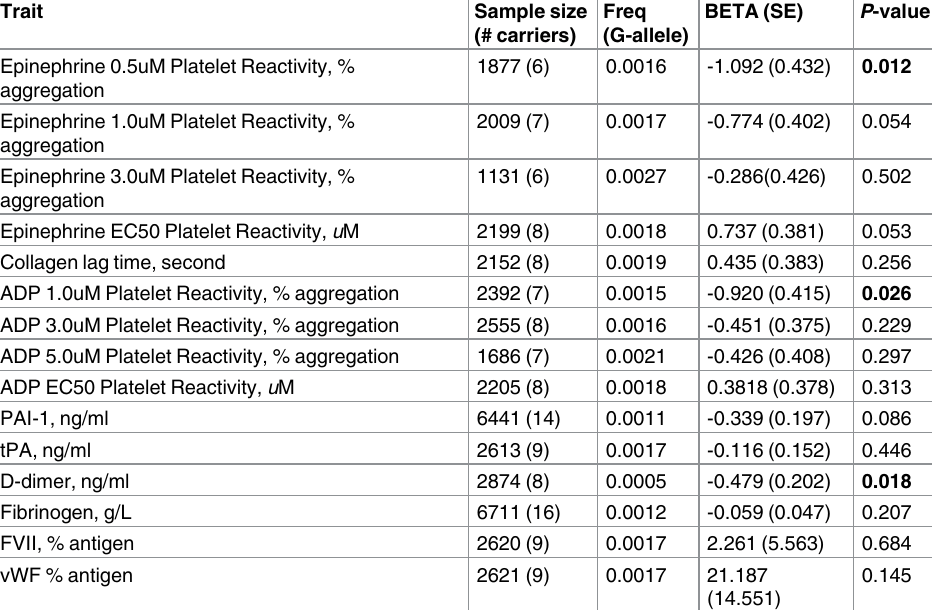
Table 2. Association results between PLG -rs145535174 and hemostatic and coagulation factors in the Framingham Heart Study. The directionof the effects (BETA) is given for the rare G-allele(on forward strand). SE, standard error; ADP, Adenosine diphosphate; PAI-1, plasminogen activator inhibitor type 1; tPA, tissue plasminogen activator; FVII, factor VII; vWF, von Willebrandfactor. We highlightin bold nominalP-val- ues <